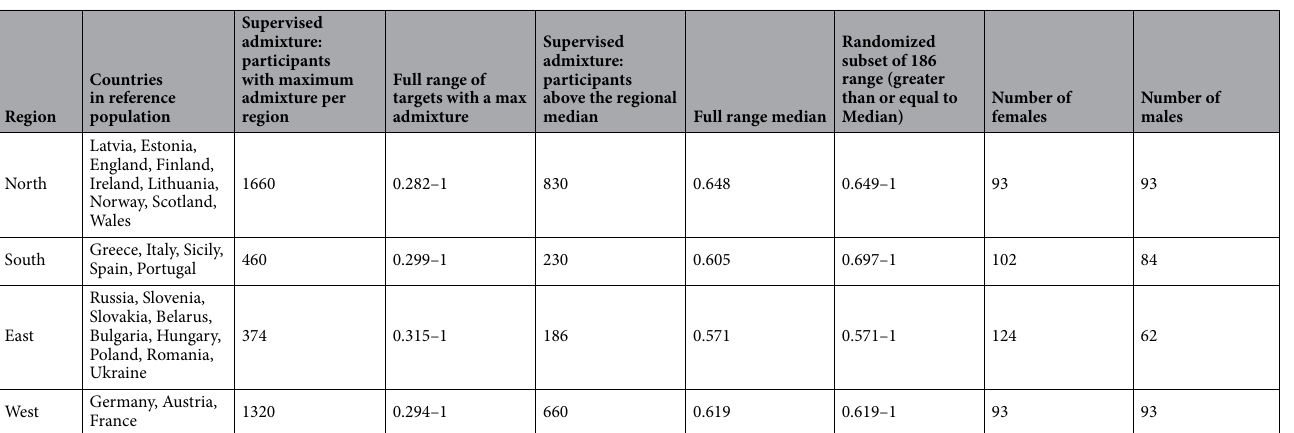
Table 1. Genetic ancestry distribution of the four cartesian regions of Europe and composition of the regional